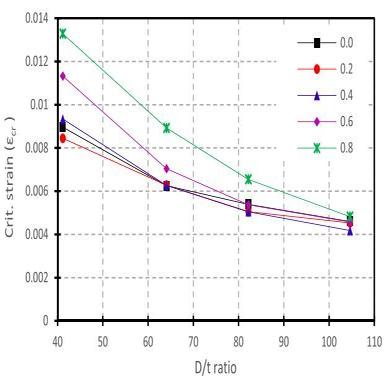
Plot of εcr vs. D/t ratio for X70 pipe (PL/US = 0.73).